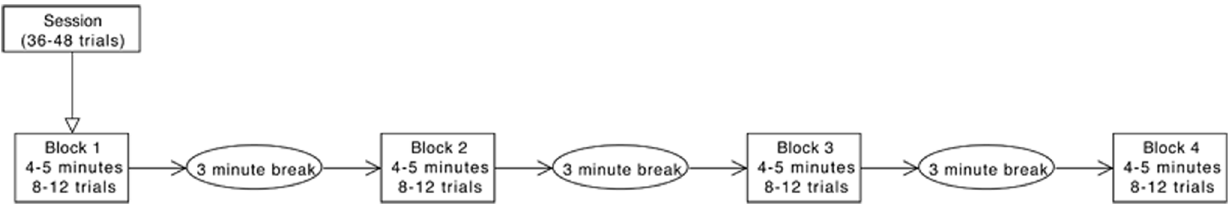
Figure 2. A visual representation of training and testing session structure. Each session has a total of 32–48 tone presentations, depending on the phase (see Table 3). The tones are presented in 4 blocks, with a 3-minute rest period between blocks.